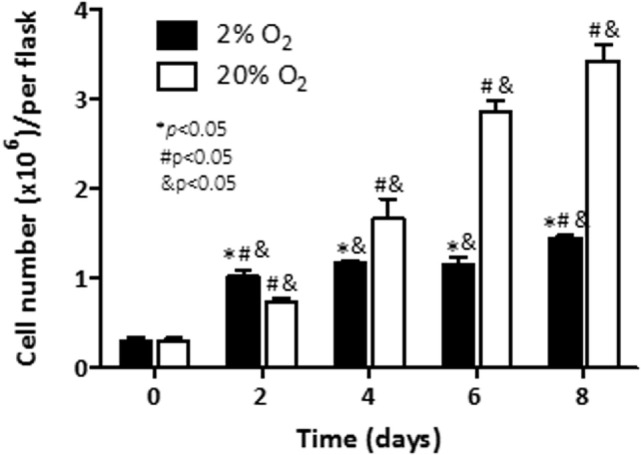
Effect of hypoxia on cell viability: C4-2B cells were cultured at under hypoxia (■) or normoxia (□). Alive cells were counted in triplicate flasks using trypan blue exclusion to differentiate dead cells. *p < 0.05 when data at 2% O2 are compared to values at 20% O2 at the same time point; #p < 0.05 when data at 2% O2 or 20% O2 are compared to a previous time point within the same O2%; and &p < 0.05 when a specific data point is compared to the point at day 0 within the same O2%.